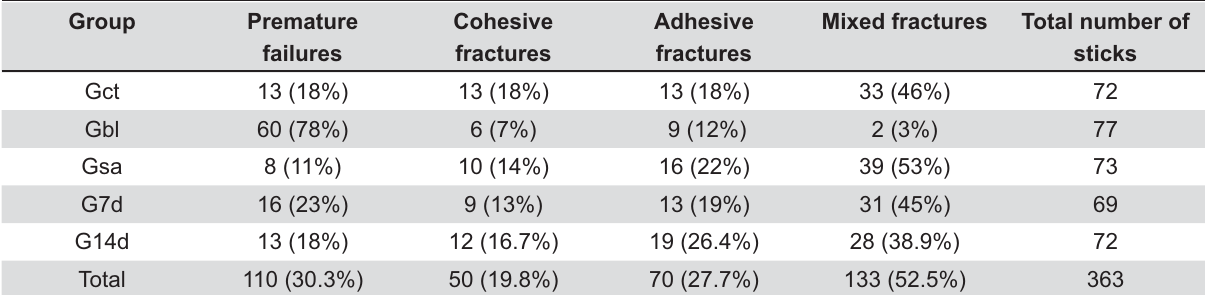
Table 1- Premature failures and fracture modes observed in the experimental groups, N